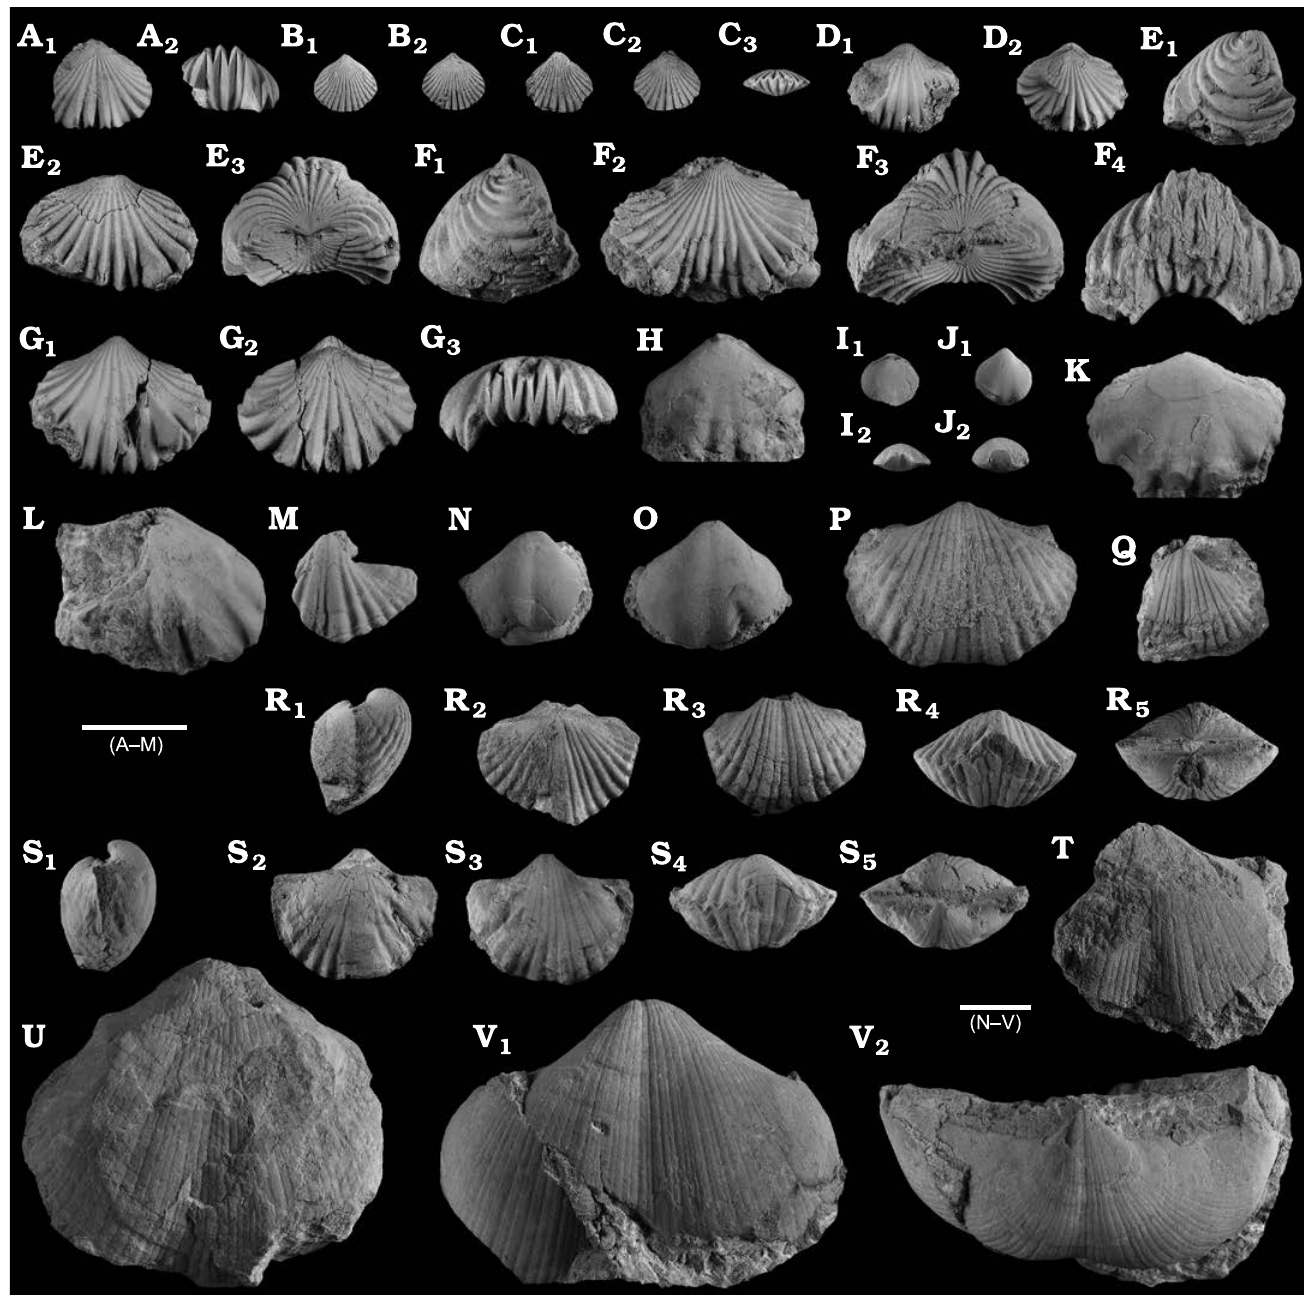
Fig. 14. Rhynchonellida and Spiriferida from the Brigantian (uppermost Visean) of Ricklow Quarry, near Monyash (localities RCC-, RCK-; Fig. 3) and Wensley Dale, near Matlock (locality WI1; Fig. 2), Derbyshire, UK. A – G . Pleuropugnoides pleurodon (Phillips, 1836). A . MPUM12011 (RCC49-22) in dorsal (A 1 ) and anterior (A 2 ) views. B . MPUM12013 (RCK15-4) in ventral (B 1 ) and dorsal (B 2 ) views. C . MPUM12017 (RCK15B-3) in ventral (C 1 ), dorsal (C 2 ), and anterior (C 3 ) views. D . MPUM12015 (RCK15-19) in ventral (D 1 ) and dorsal (D 2 ) view. E . MPUM12014 (RCK15-15) in lateral (E 1 ), ventral (E 2 ), and posterior (E 3 ) views. F . MPUM12012 (RCC73-9) in lateral (F 1 ), ventral (F 2 ), posterior (F 3 ), and anterior (F 4 ) views. G . MPUM12016 (RCK15-29) in ventral (G 1 ), dorsal (G 2 ), and anterior (G 3 ) views. H – L . Propriopugnus pugnus (Martin, 1809). H . MPUM12021 (RCC2-55) in dorsal view. I . MPUM12022 (RCC3-7) in dorsal (I 1 ) and anterior (I 2 ) views. J . MPUM12024 (RCC73-22b) in ventral (J 1 ) and anterior (J 2 ) views. K . MPUM12026 (RCC60-4d) dorsal valve in dorsal view. L . MPUM12028 (WI1-33) in dorsal view. M . ? Fusella sp., MPUM12037 (RCC128-5) ventral valve in ventral view. N , O . Martiniinae gen. et sp. indet. N . MPUM12065 (RCC2-58a) ventral valve in ventral view. O . MPUM12066 (WI1-32) ventral valve in ventral view. P – S . Angiospirifer bisulcatus (Sowerby, 1825). P . MPUM12032 (WI1-12a) in ventral view. Q . MPUM12035 (WI1-11) ventral valve in ventral view. R . MPUM12031 (WI1-10) in lateral (R 1 ), dorsal (R 2 ), ventral (R 3 ), anterior (R 4 ), and posterior (R 5 ) views. S . MPUM12033 (WI1-30) in lateral (S 1 ), dorsal (S 2 ), ventral (S 3 ), anterior (S 4 ), and posterior (S 5 ) views. T – V . Latibrachythyris cf . crassa (De Koninck, 1843). T . MPUM12039 (RCC1-34a) ventral valve in ventral view. U . MPUM12038 (RCC1-21) ventral valve in ventral view. V . MPUM12041 (RCC54-17a) ventral valve in ventral (V 1 ) and posterior (V 2 ) views. Scale bars 10